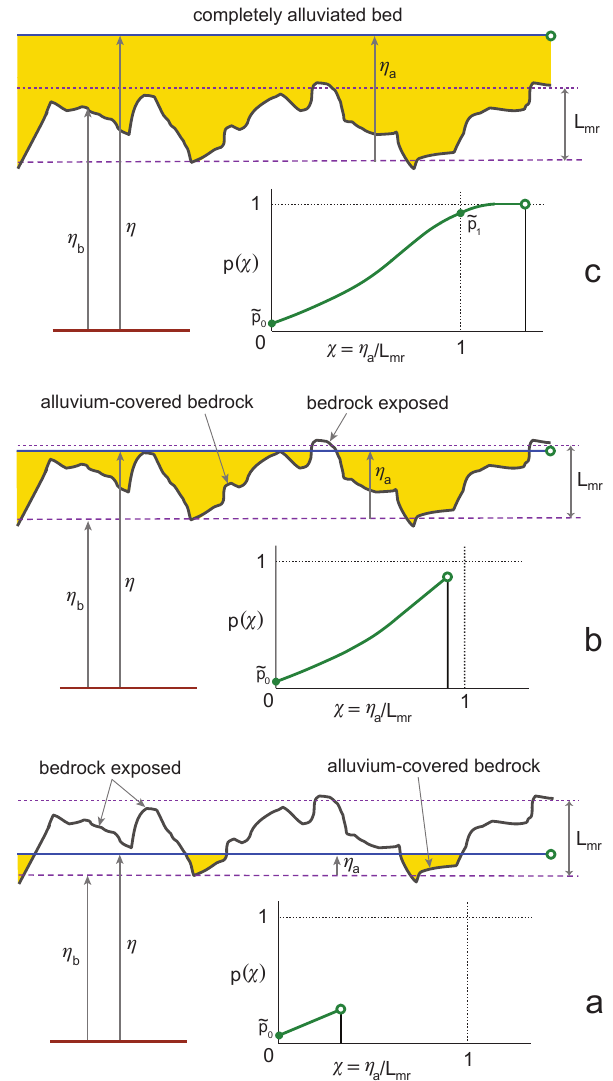
Figure 6. Illustration of the MRSAA model relation between areal fraction of alluvial cover of bedrock p(χ) (green curves) and χ = η a /L mr , where η a is the thickness of alluvium (yellow fill) and L mr is the macro-roughness height, for (a) low cover, (b) interme- diate cover (c) complete alluviation above the top of the bedrock. The diagrams show alluvium–water interfaces at spatially constant elevations (blue lines). This is for illustrative purposes only: the in- terfaces should instead be those that result from averaging over an appropriate spatial